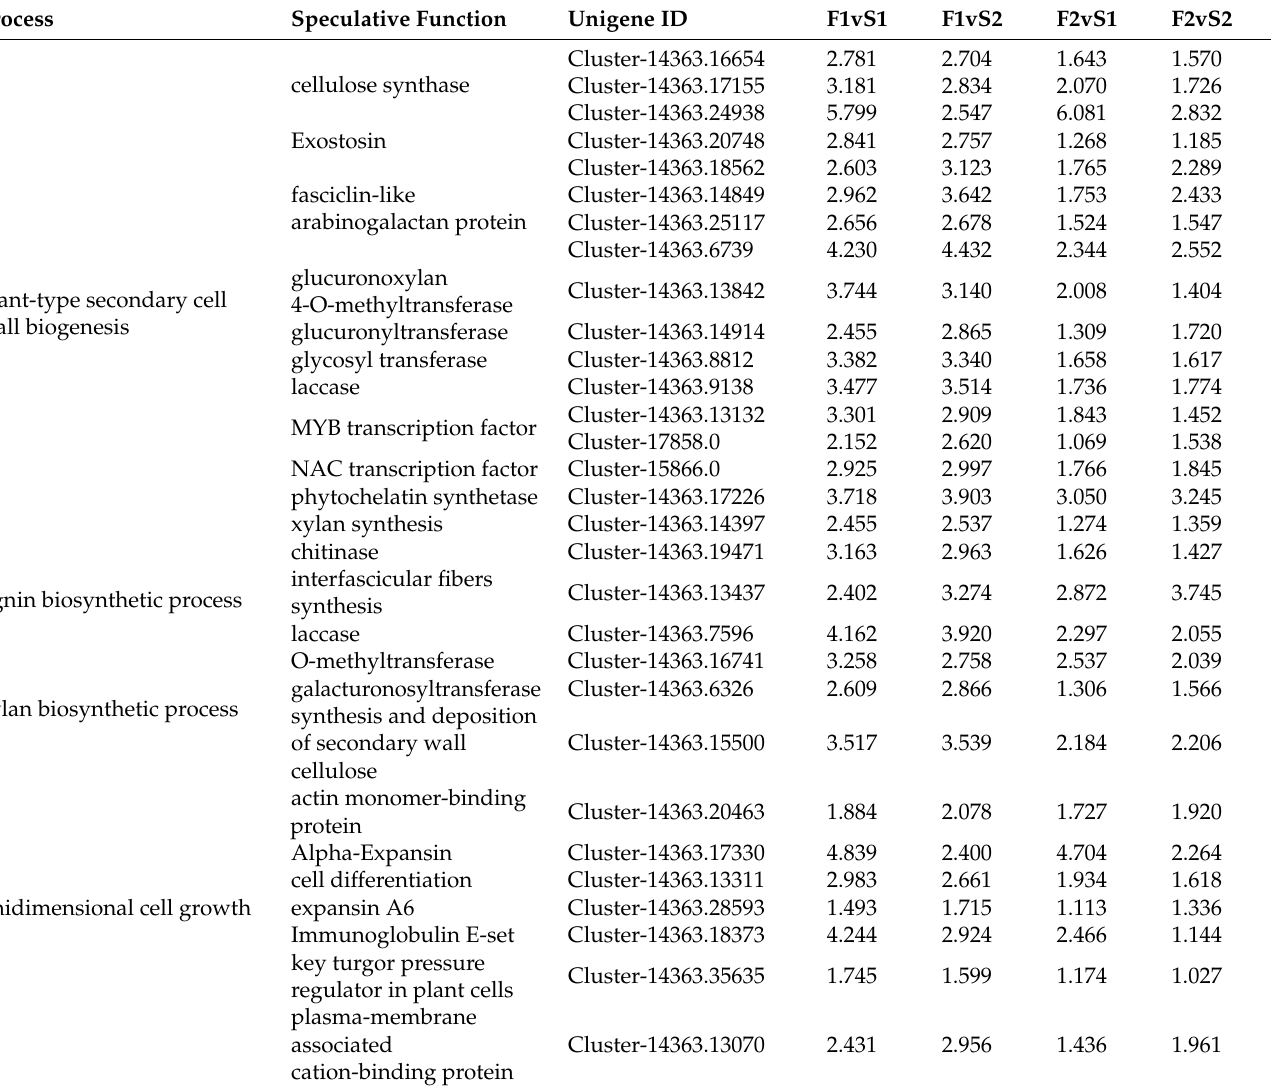
Table 3. The fold change ratio of genes in several key vascular development and transcriptional regulation